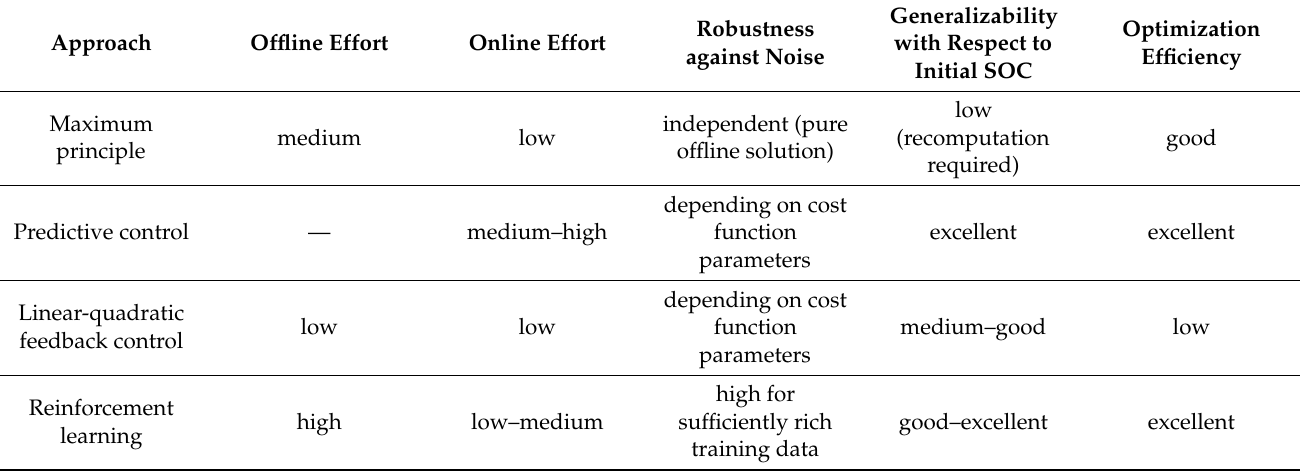
Table 1. Summary of the algorithmic properties of the considered control